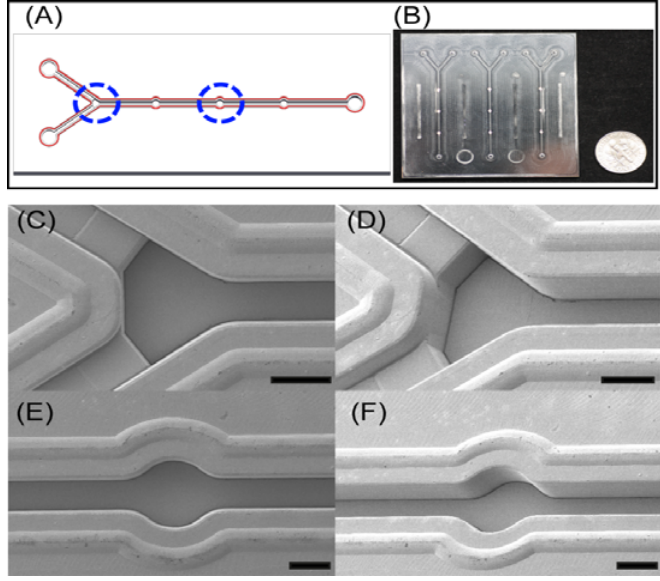
Figure 2. ( A ) Schematic illustration of microfluidic device and ( B ) its picture. SEM images of the ( C – D ) Y-junction and ( E – F ) detection chamber. All SEM images were shown in both top angle and tilted angle, and inserted scale bars are 500 μ